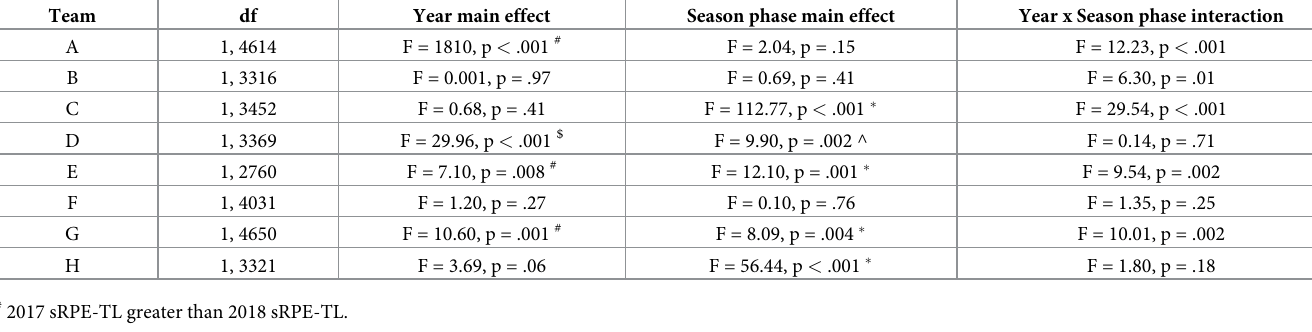
Table 1. Results of the linear mixed model for each individual